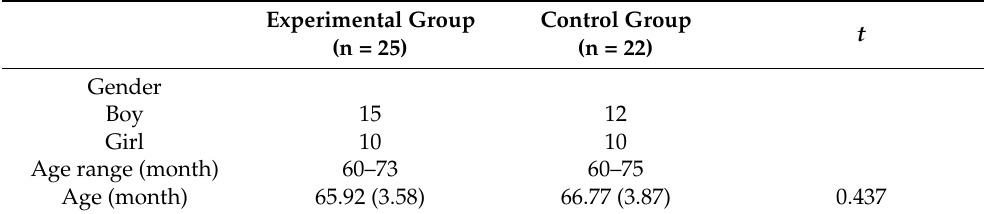
Table 1. The demographic description for the experimental and control